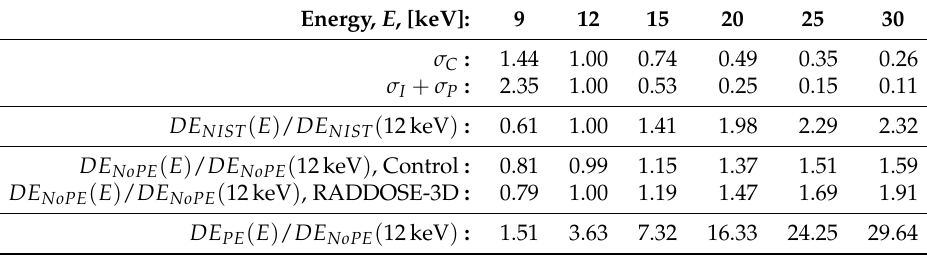
Table 1. Cross-section data and diffraction efficiency for a lysozyme crystal with 36% solvent, as described in Section 4.1, relative to the reference values DE NIST ( 12keV ) and the RADDOSE-3D [9] value for DE NoPE ( 12keV ) . Cross-sections for coherent scatter, σ C , incoherent scatter, σ I , and photoelectric absorption, σ P , were calculated using the NIST XCOM database [25]. Diffraction efficiency was calculated as the ratio σ C / ( σ I + σ P ) from cross-section data and the ratio of coherently scattered photons per unit volume, N C / σ 3 , to average global dose, D G , for simulations. DE NoPE values are averages across all beam X and crystal sizes simulated. DE PE values are for a 1µm crystal in a 1µm